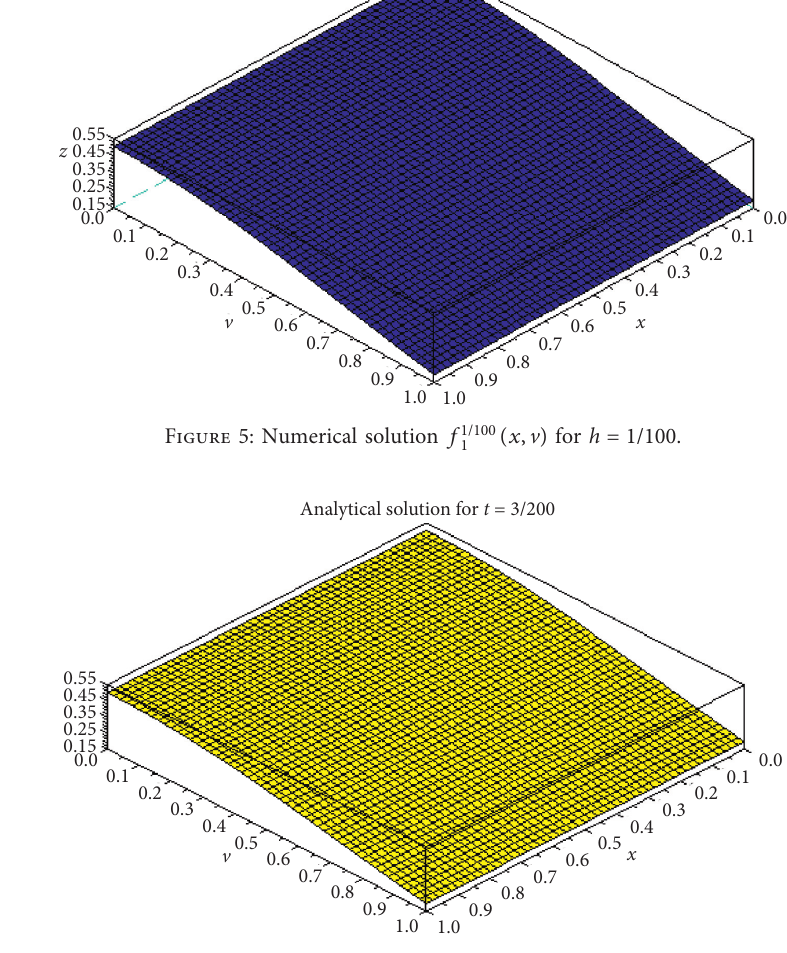
Figure 6: Analytical solution f ( 3/200 , x, v ) for h � 1/100 and t � 3/200 ∈ [ 1/100 , 1/50 ) .